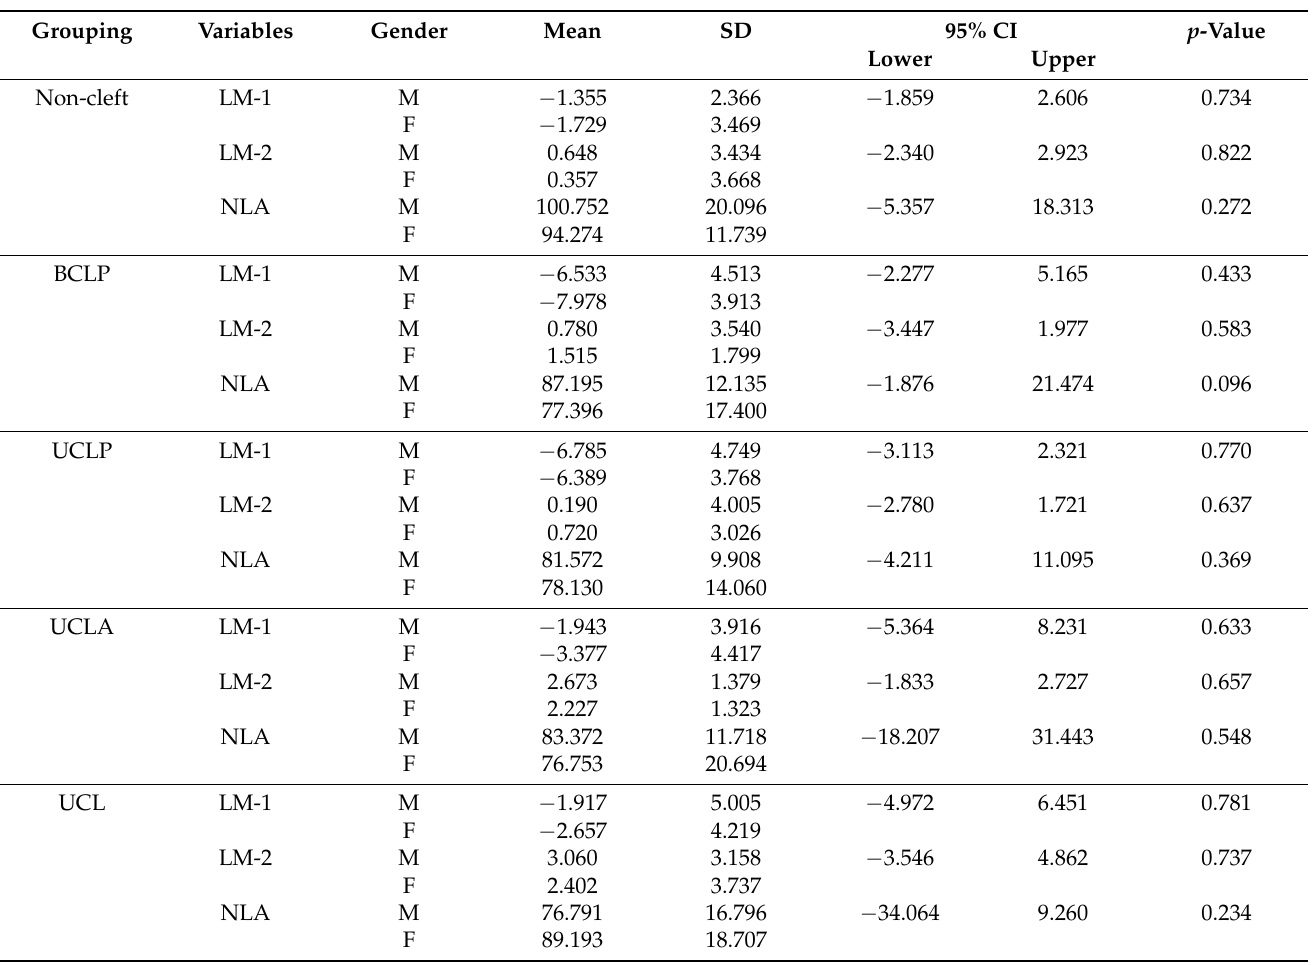
Table 3. Gender disparities for Upper lip to E plane (LM-1), Lower lip to E plane (LM-2), and Nasolabial angle (NLA) among non-cleft and cleft